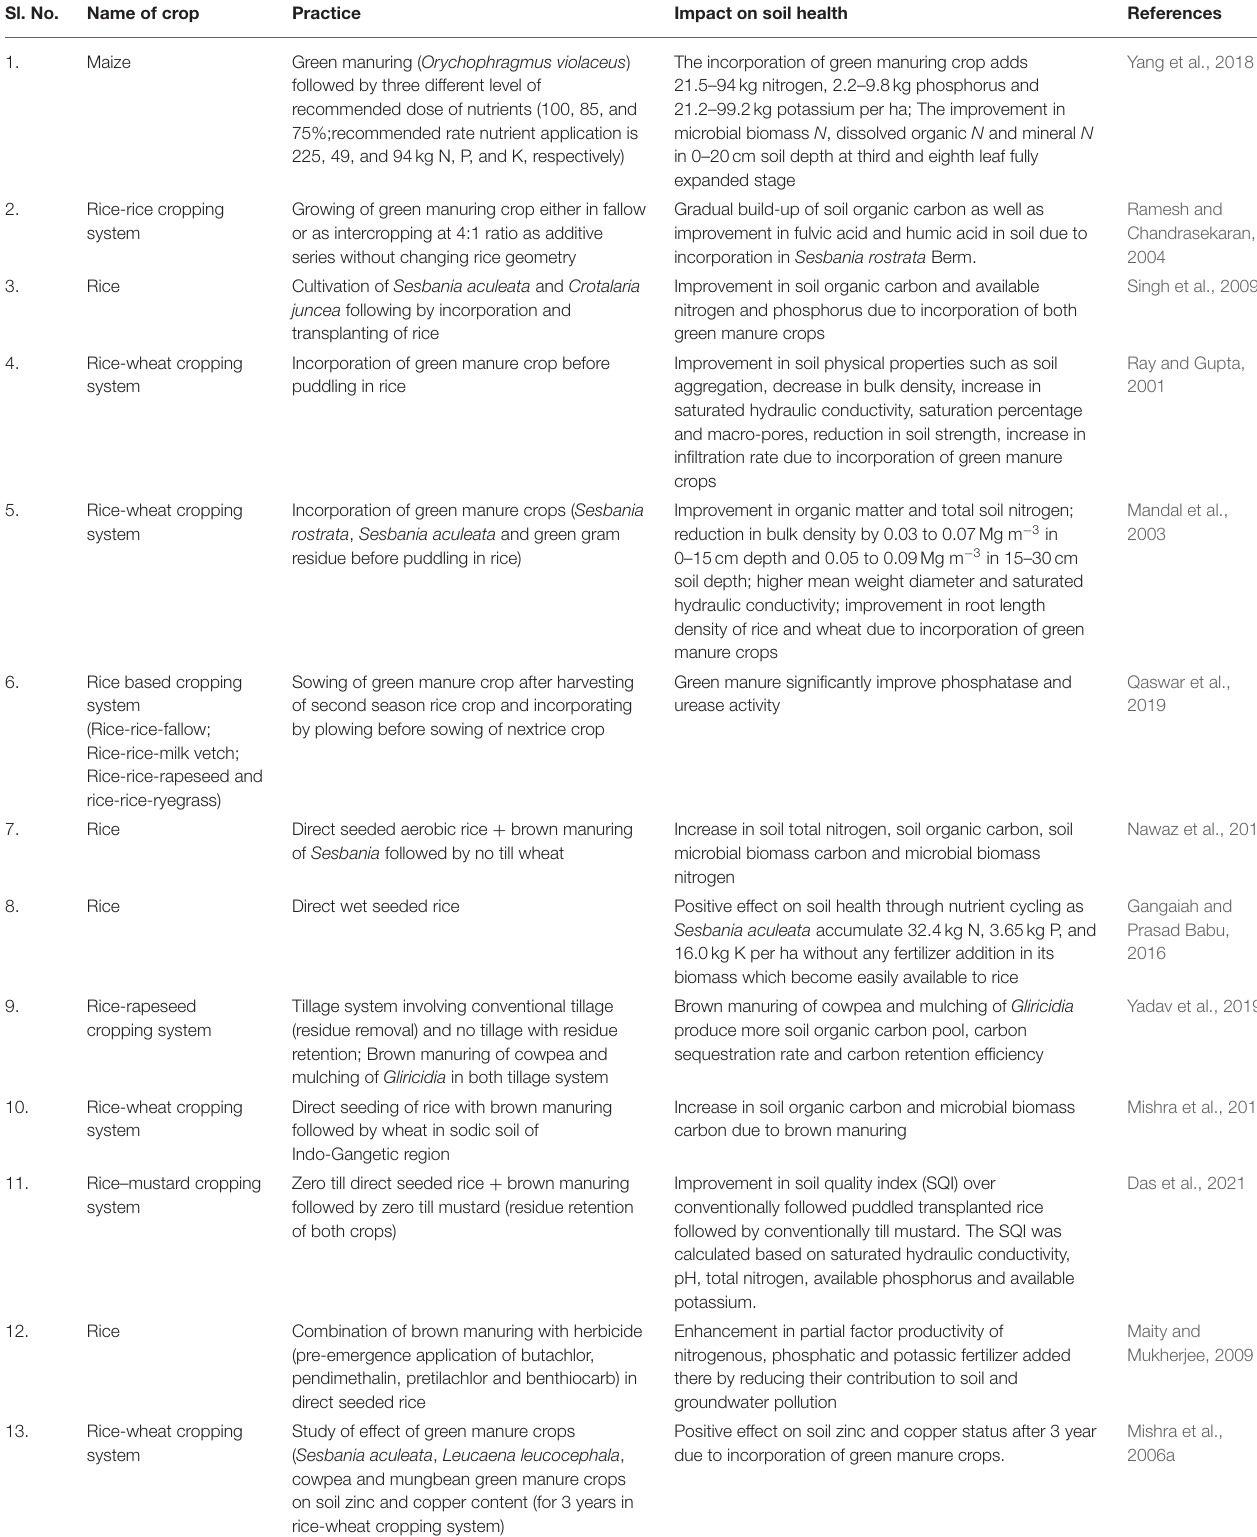
TABLE 10 | Effects of green and brown manuring on soil health. Sl.